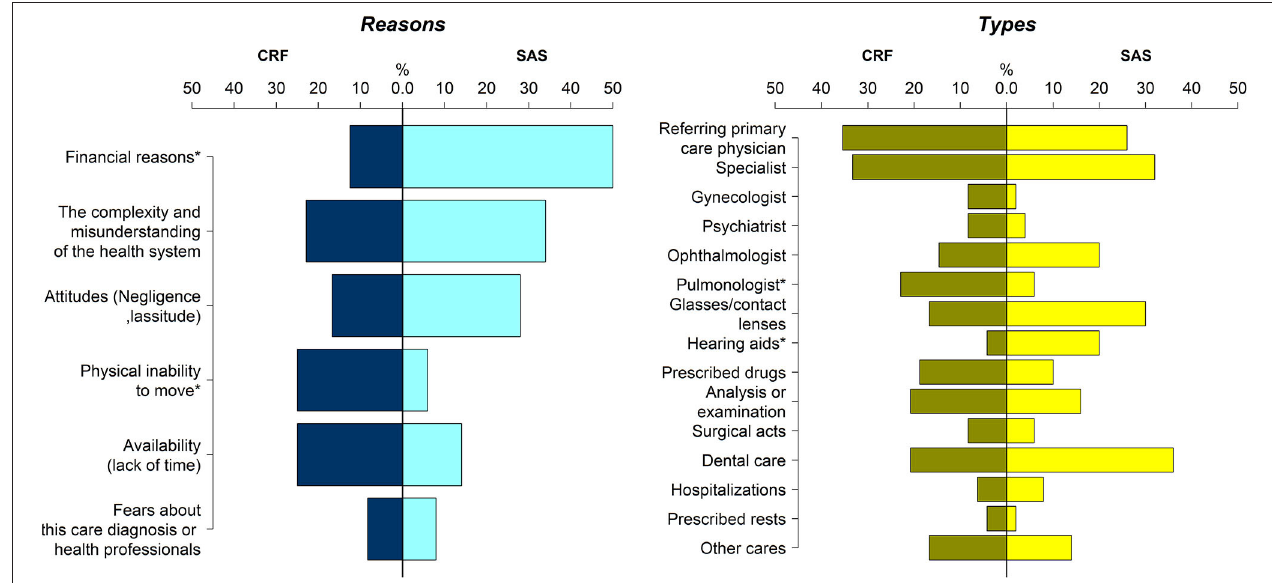
FIGURE 1 | Differences in the pattern of healthcare non-take up between OSAS and CRF patients. The rate of each type of healthcare type forgone and the reasons of the non-take up are presented as percentages (%).